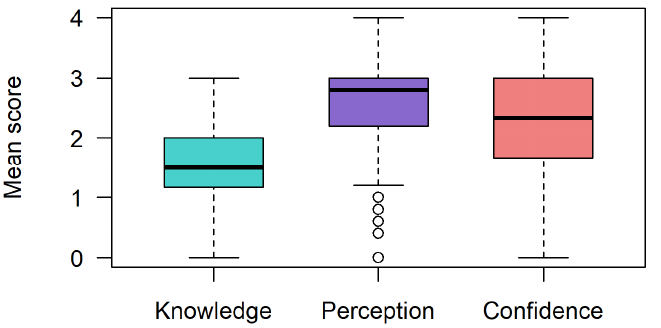
Figure 1. Respondents’ overall mean knowledge, perception and confidence scores. Mean scores calculated per individual across items relating to knowledge, perception and